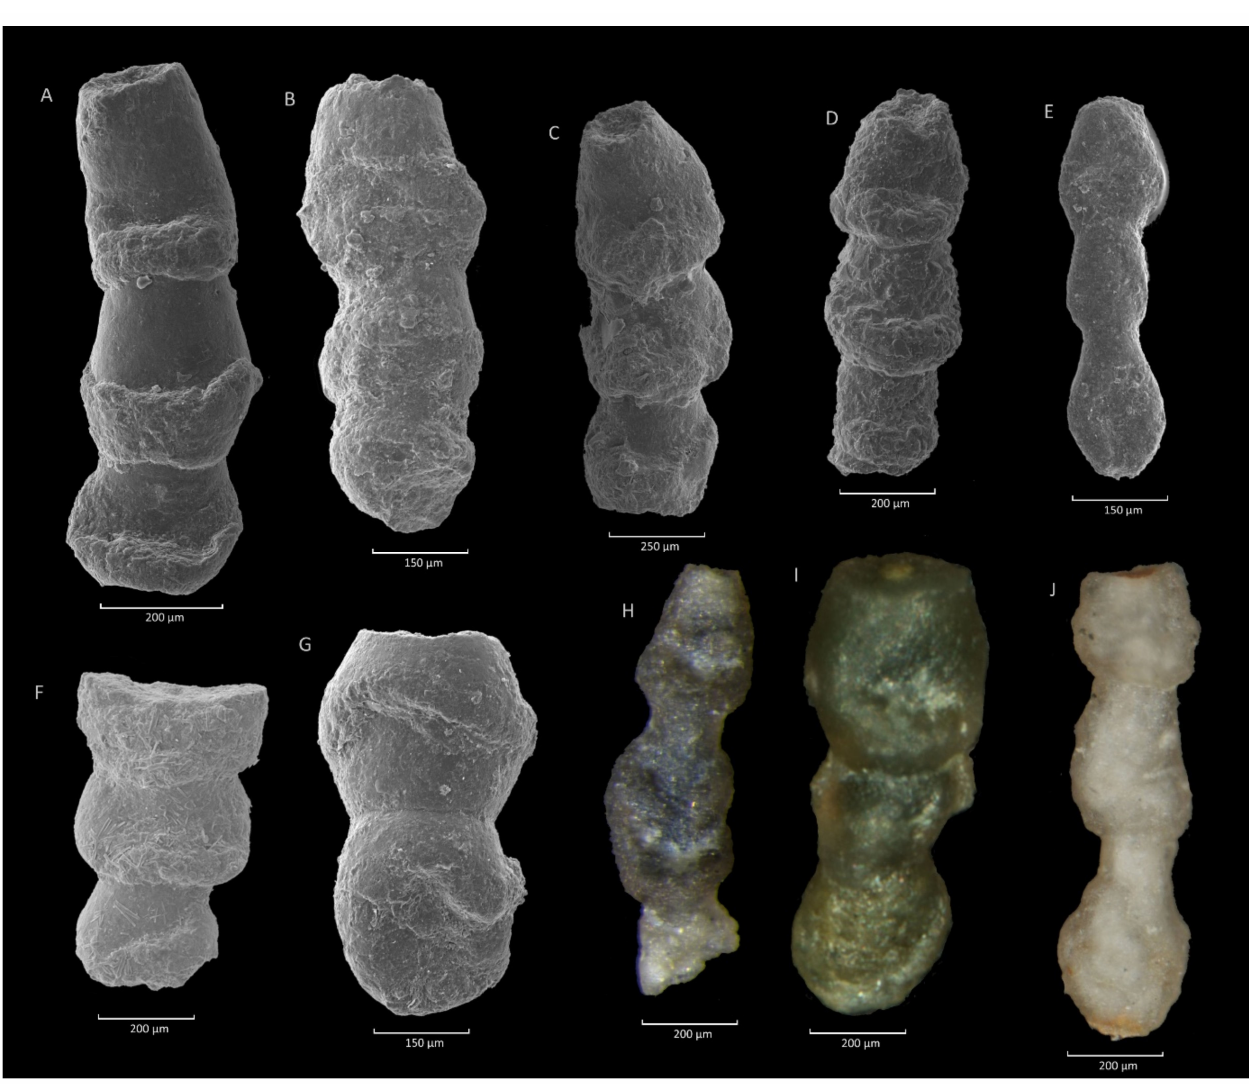
Figure 11. Hormosina velascoensis (Cushman). ( A ): Stradomka section; ( B , E , F ): Zimny Dział section; ( C ): Gorze´n section; ( D , G , I ): Szydłowiec section; ( H ): Ropica section; ( I , J ): Szymbark